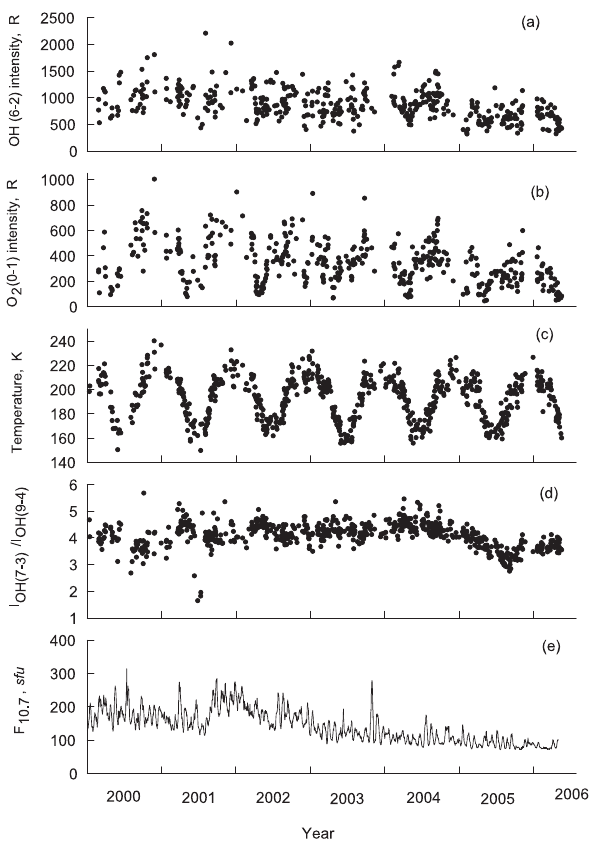
Fig. 2. Midnight data on intensities of the OH band (6-2) (a) and O 2 Atmospheric band (0-1), hydroxyl temperature (b) , ratio of the (7-3) and (9-4) OH band intensities (I OH ( 7 − 3 ) /I OH ( 9 − 4 ) ) and Penticton solar radio flux (F 10 . 7 ) .